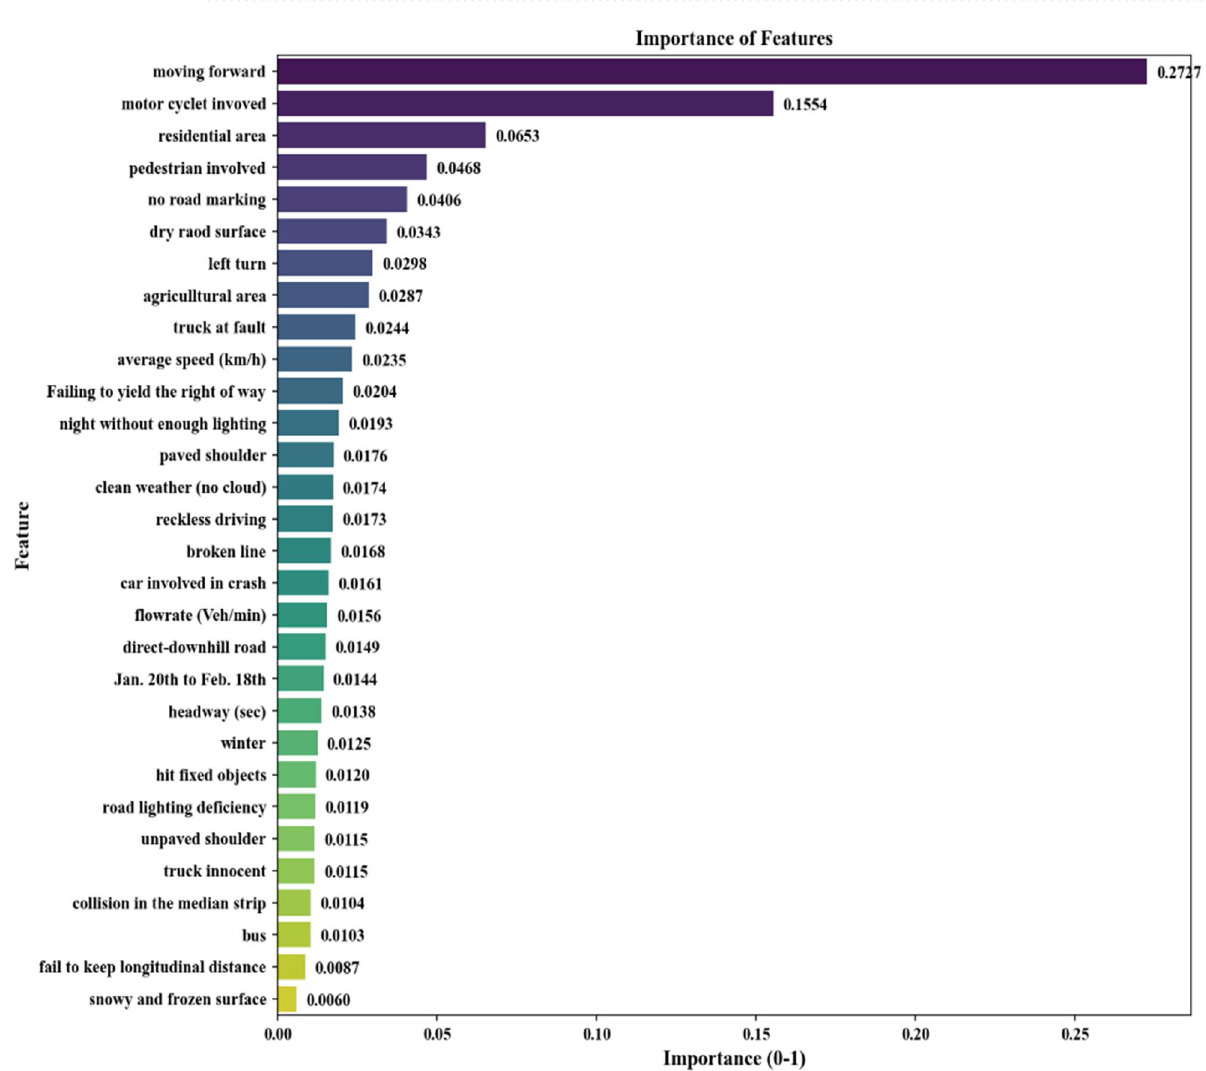
Figure 2. ROC curves for the ERT model [plotted by Python Matplotlib v. 3.3.4 https:// matpl otlib. org].